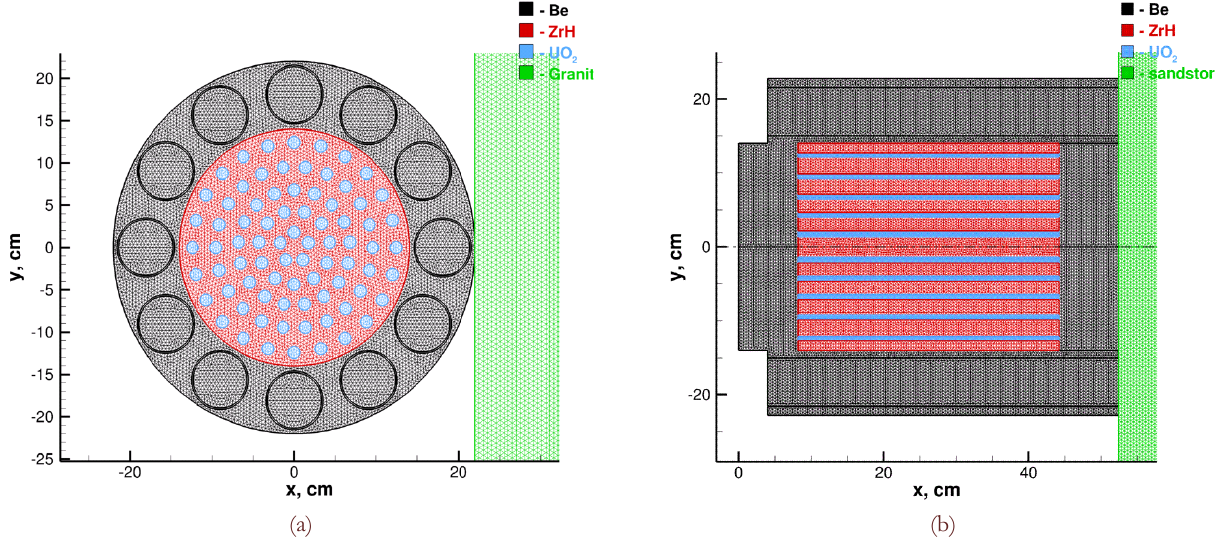
Figure 1: (a) Reactor "Topaz" with plane geometry; (b) Reactor "Topaz" with axial